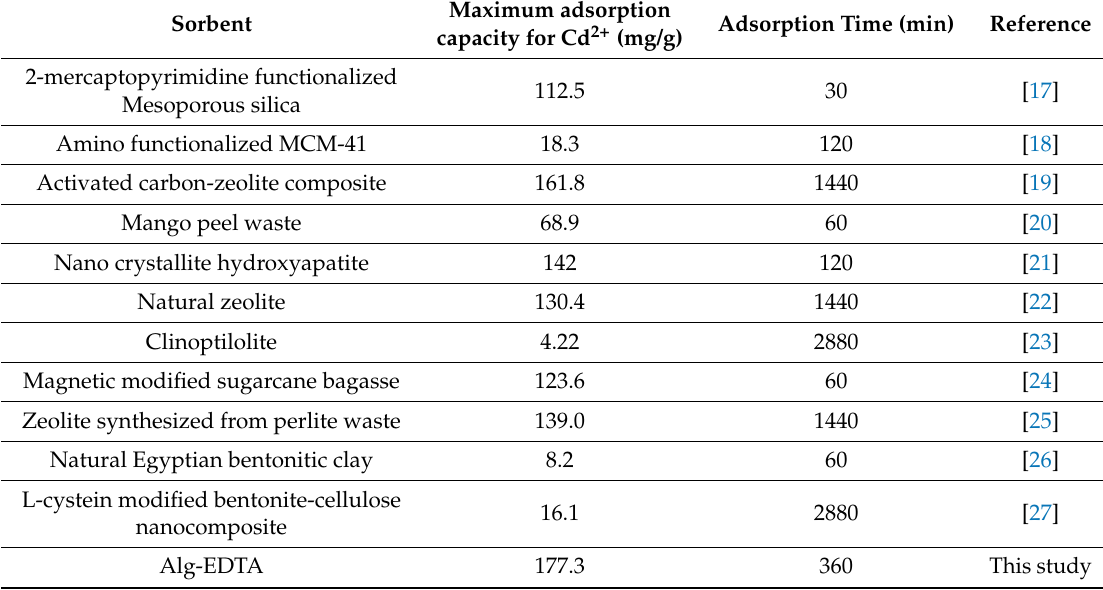
Table 4. The adsorption capacity of different heavy metal ions sorbents for Cd 2+